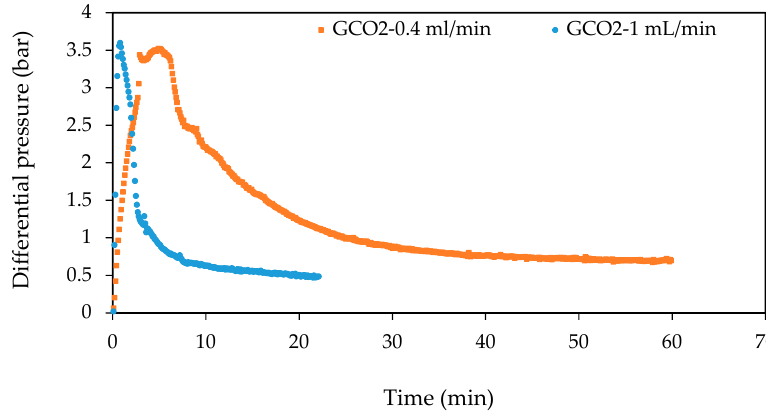
Figure 13. Effect of injection rate on the differential pressure profile of low-pressure GCO 2 –oil displacements conducted at 40 bar and 33 °C.